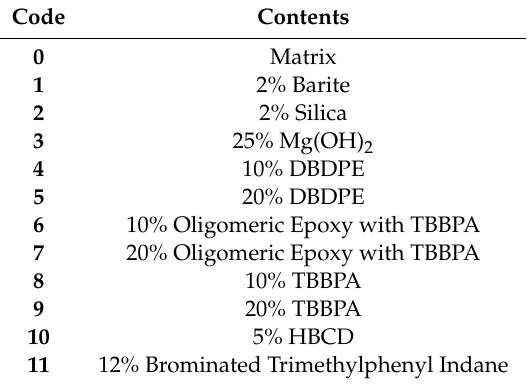
Table 1. Studied samples along with their code names.